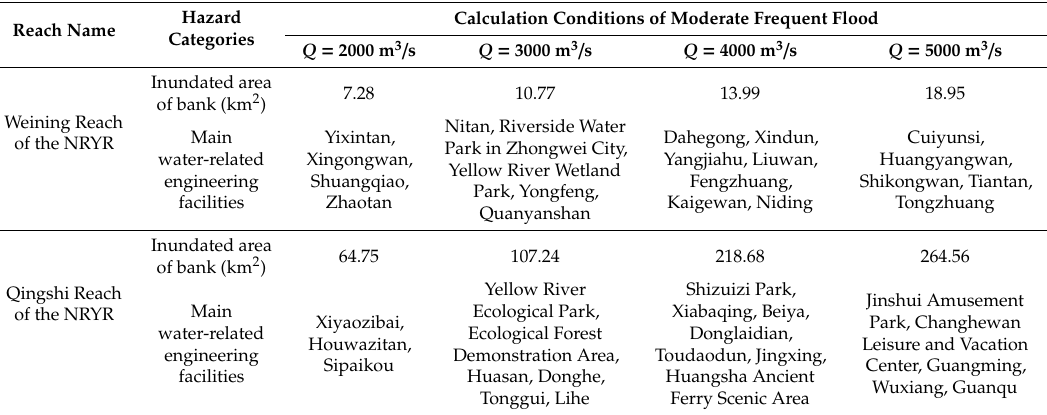
Table 1. Results of the riverbank inundation hazards resulting from the moderate frequent flooding events in the NRYR.